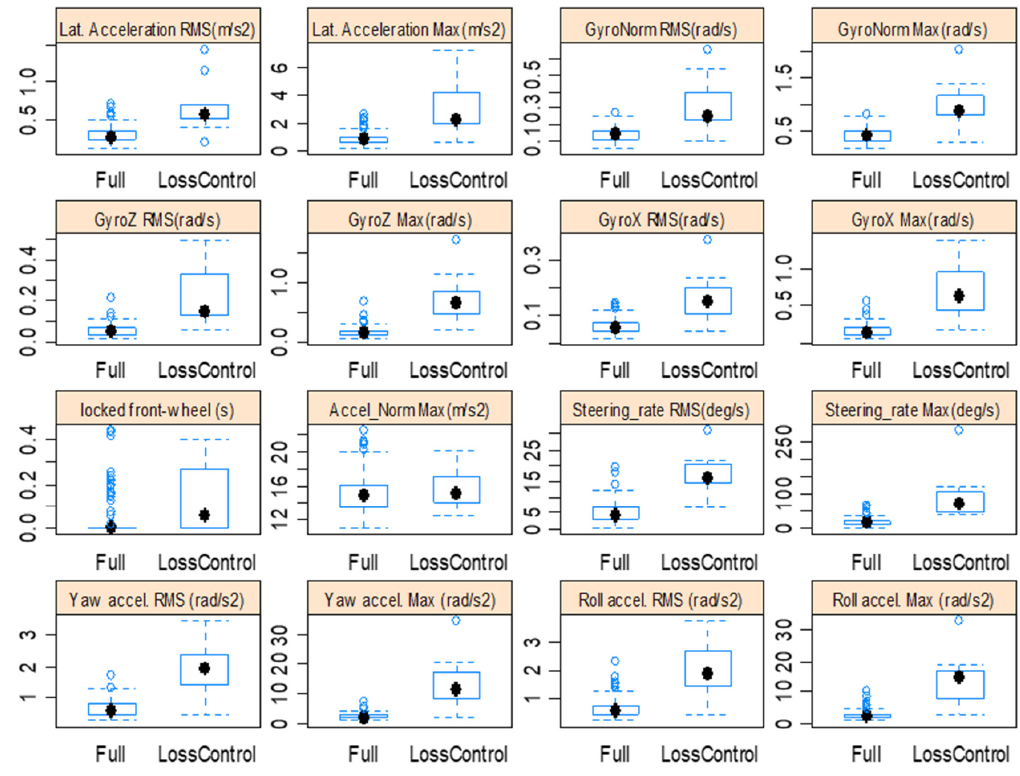
Figure 4. Box plot distribution of the predictors by Controllability level for 165 braking trials.